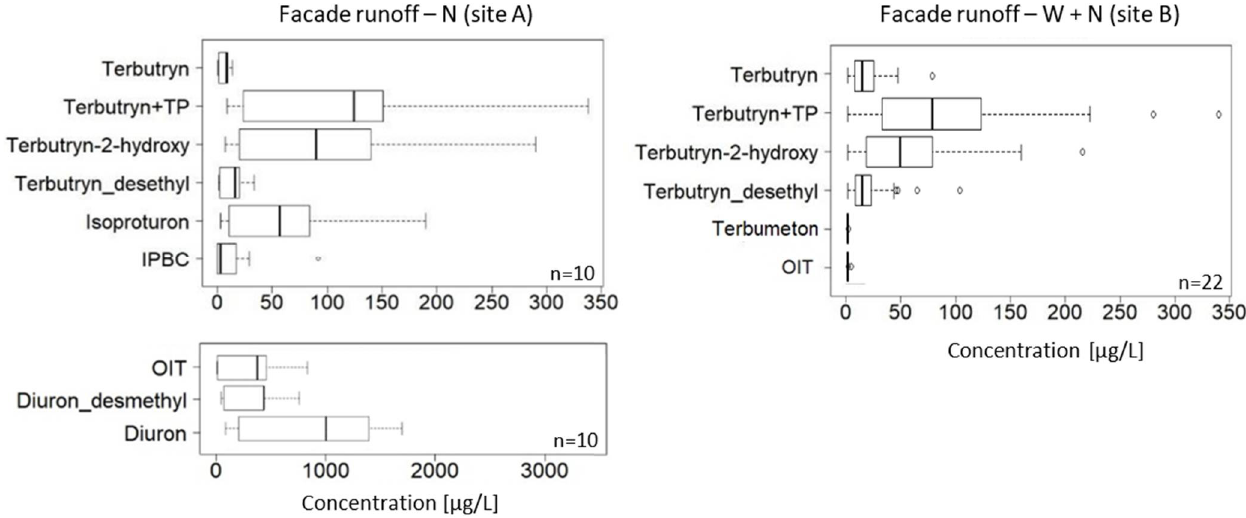
Figure 2. Concentration of biocides in façade runoff of painted façades at site A (north) and B (west and north).